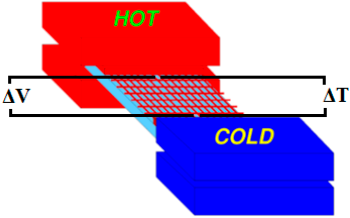
Figure 1. Schematic presentation of the Seebeck coefficient determination.